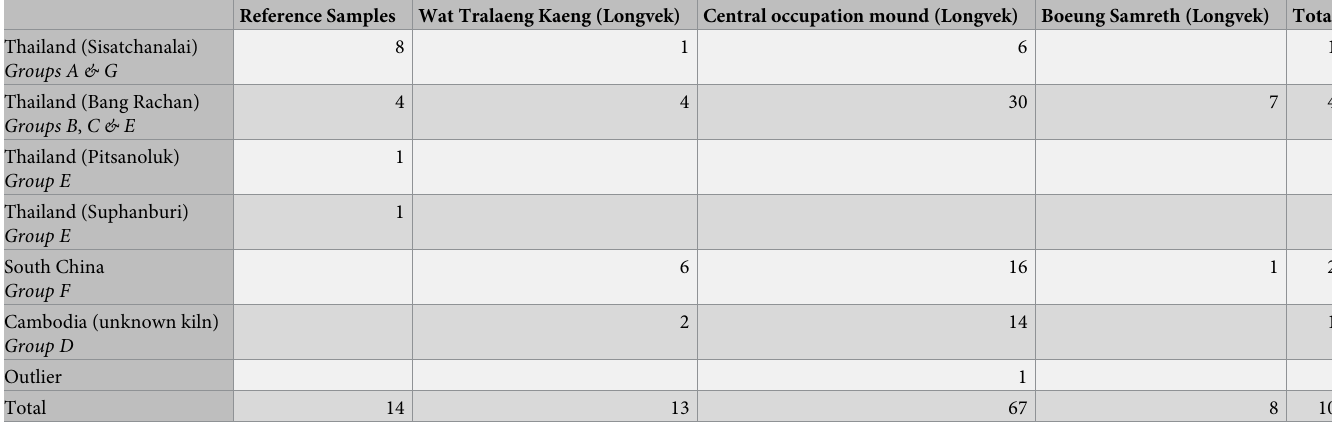
Table 1. Summary description of sherds in this